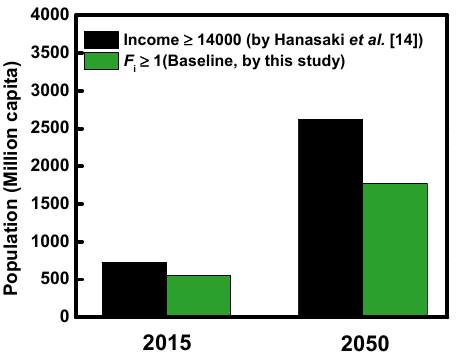
Figure 6. Simulated total global desalination population in different years under two different standards. Black and green bars show the simulation results using the criteria in Hanasaki et al. [14] and in this study, respectively.